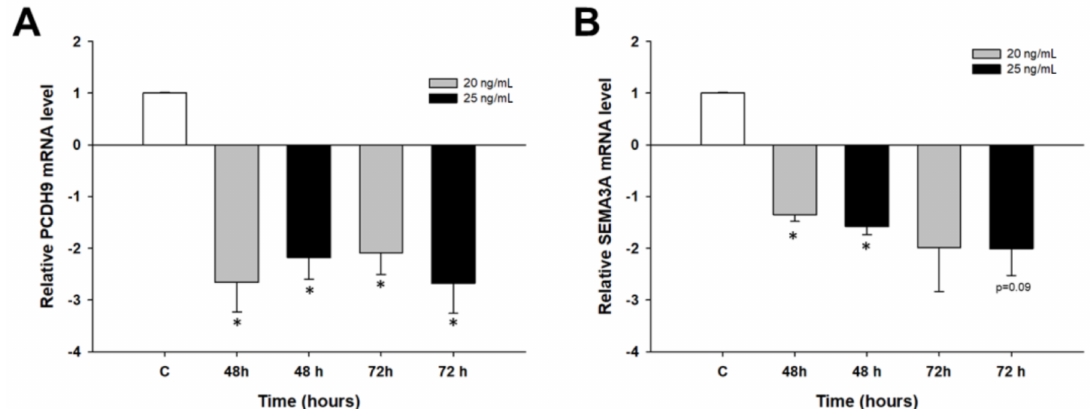
Figure 7. Expression analysis of the PCDH9 gene ( A ) and SEMA3A gene ( B ) in the A2780 cell line. The figure presents the relative gene expression in the PAC-treated cells (grey and black bars) with respect to that of the untreated control (white bars), which was assigned a value of 1. The values were considered significant at * p <